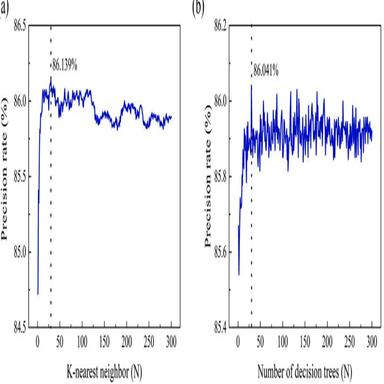
Machine learning algorithm training. (a) KNN algorithm training. (b) Random forest algorithm training.